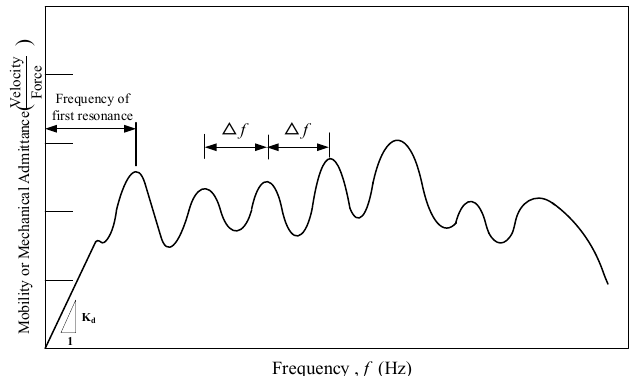
Figure 1. Theoretical mobility response spectrum tested using the TRM.